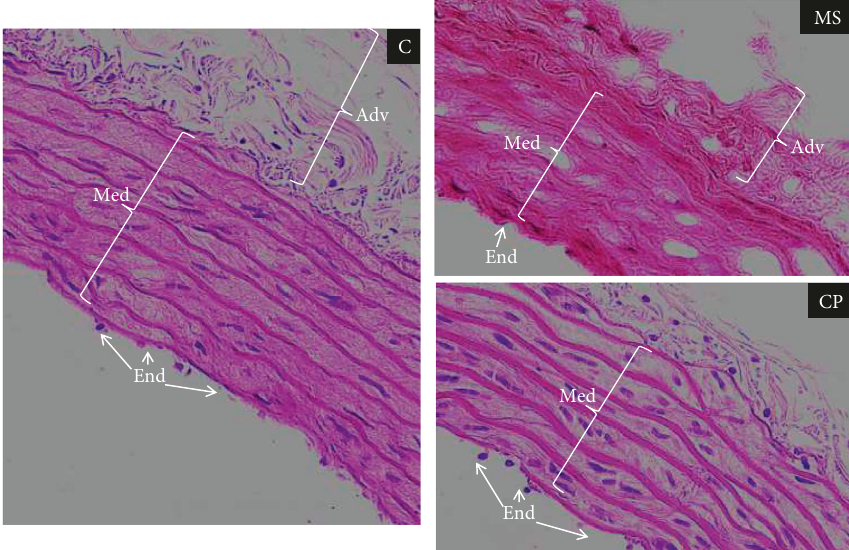
Figure 2: Photomicrographs of the rat thoracic aorta with HE staining under Control (C ), metabolic syndrome (MS) and critical period (CP) conditions. MS rats ingested sucrose solution during six months; CP animals ingested sucrose solution during postnatal days 12 to 28. Control rats received tap water. In C and CP the integrity of the tissue is observed with the endothelial cells (End) at the edge of the lumen of the vessel; elastic fibers and smooth muscle in the middle (Med) and adventitia (Adv). Bar = 25 μ